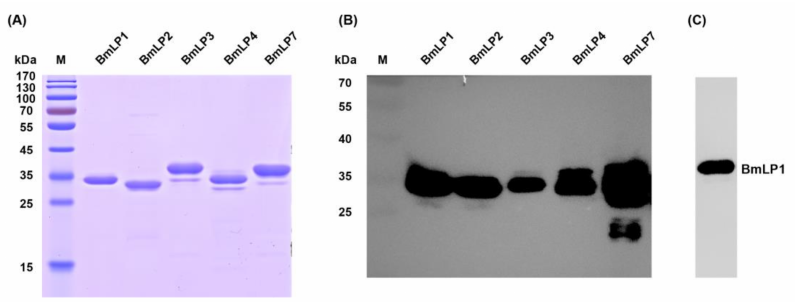
Figure 3. The purified recombinant proteins were detected by SDS-PAGE and western blotting. The SDS-PAGE gel was stained with Coomassie Brilliant Blue R250 ( A ) and western blotting was performed using mouse anti 6 × his-tag antibodies and HRP (Horseradish Peroxidase)-conjugated goat anti mouse antibodies ( B ). The purified recombinant BmLP1 was detected by western blotting with BmLP1 specific polyclonal antibodies ( C ).